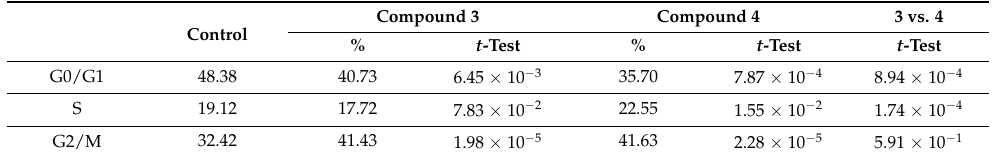
Figure 13. Dose-dependent inhibition of P19 cells exposed to compounds 3 (blue) and 4 (red). Poly ( 3 ): y = − 9 × 10 − 11 x 4 + 3 × 10 − 7 x 3 – 0.0004x 2 + 0.3155x + 0.5655; R² = 0.9955. Poly ( 4 ): y = − 5 × 10 − 10 x 4 + 1 × 10 − 6 x 3 – 0.0014x 2 + 0.6012x + 8.4036; R² = 0.9826